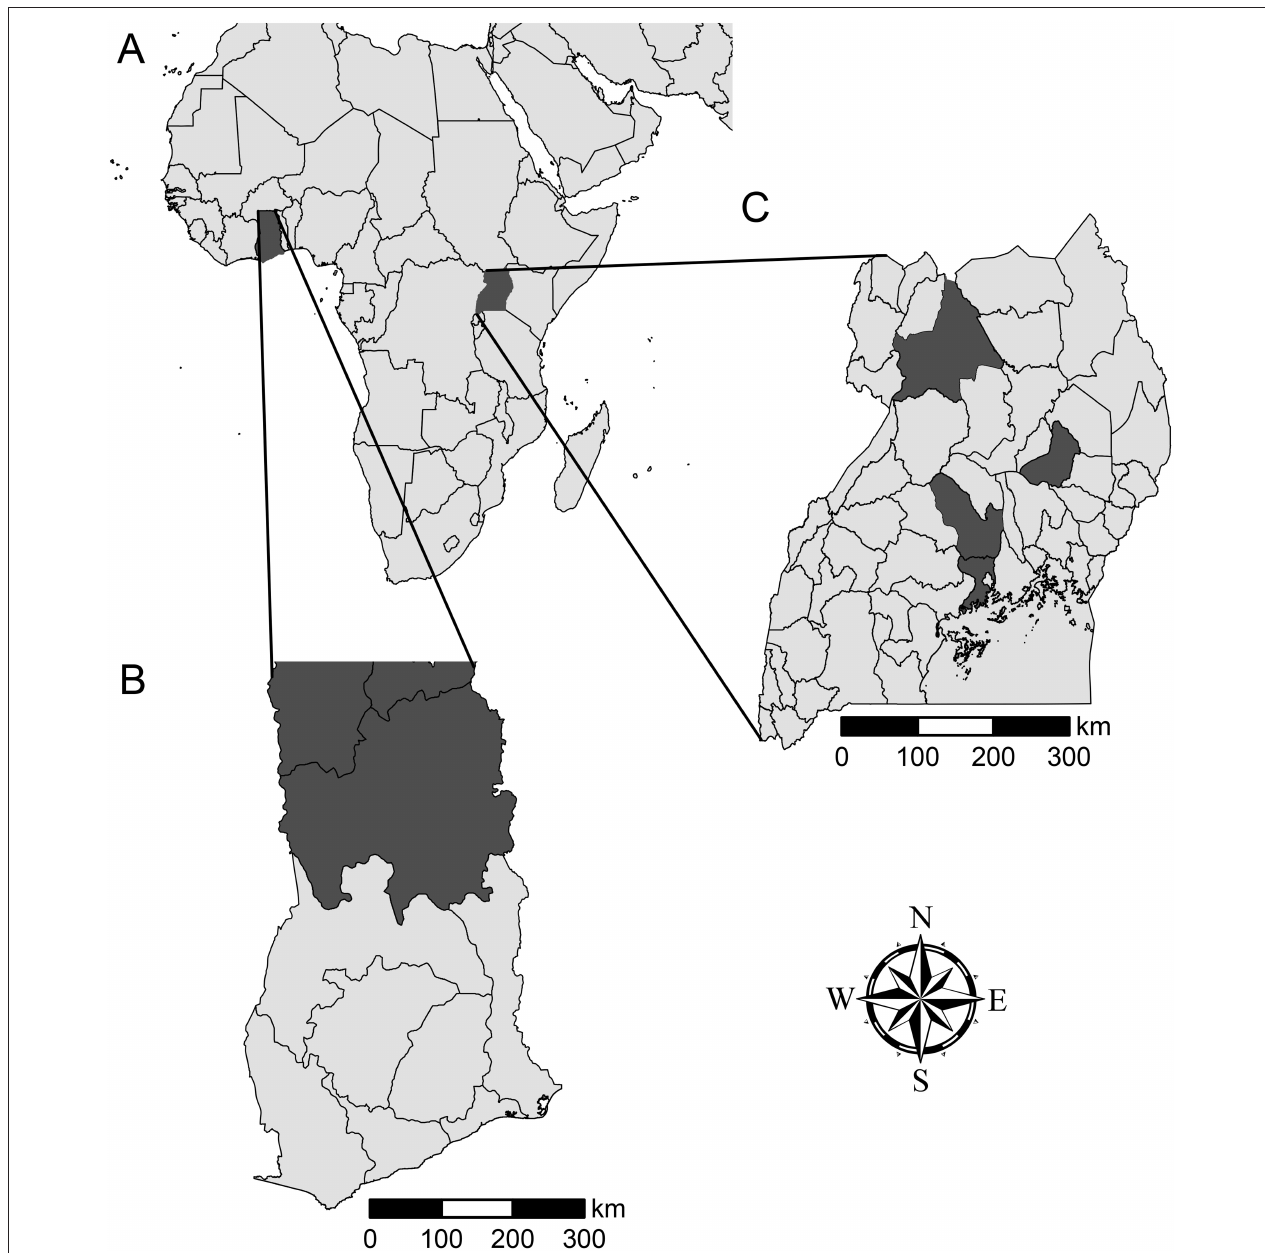
FIGURE 1 | Research sites. (A) Overview of Africa with Ghana and Uganda highlighted. (B) Overview of Ghana, with the districts of Northern, Upper East, and Upper West highlighted. (C) Overview of Uganda, with the districts of Gulu, Soroti/Serere, and Wakiso highlighted.